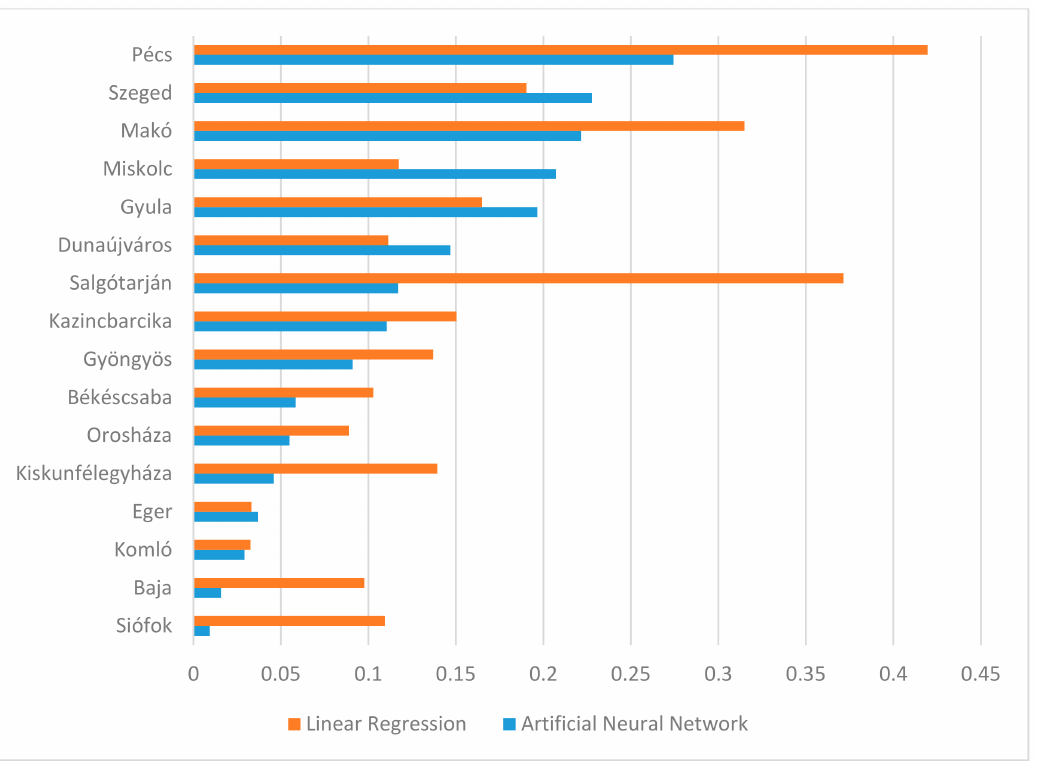
Figure 12. The difference between the true and estimated values, in absolute